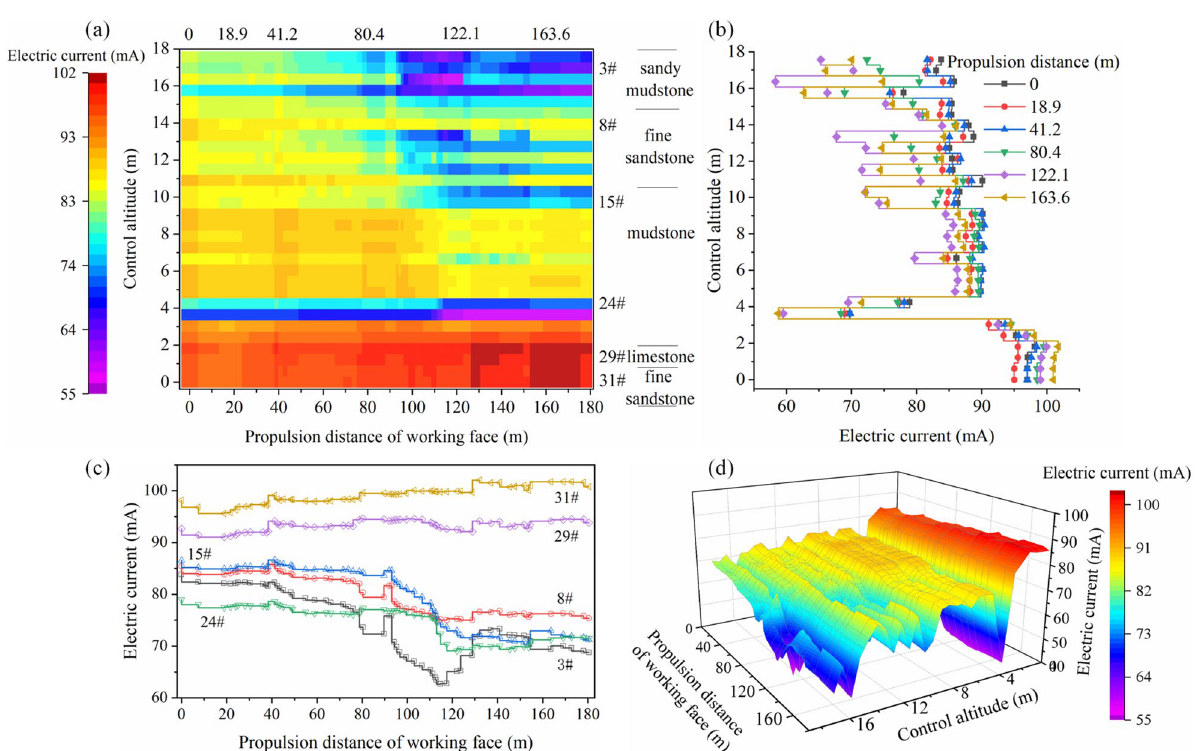
Figure 7. Changes in excitation current in the roadway-surrounding rock during